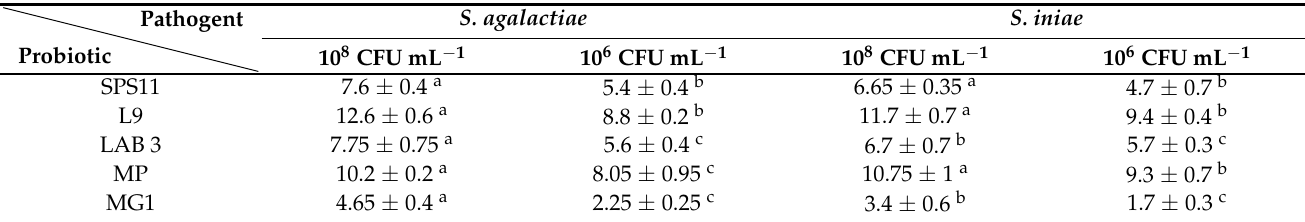
SPS11: Lysinibacillus fusiformis, L9: Bacillus amyloliquefaciens , LAB3: Enterococcus hirae , MP: Mixed probiotics (SPS11, L9, and LAB3), MG1: Commercial probiotics. Supercript a,b,c at different alphabetical letters indicate a statistically significant difference (One-way ANOVA, p <